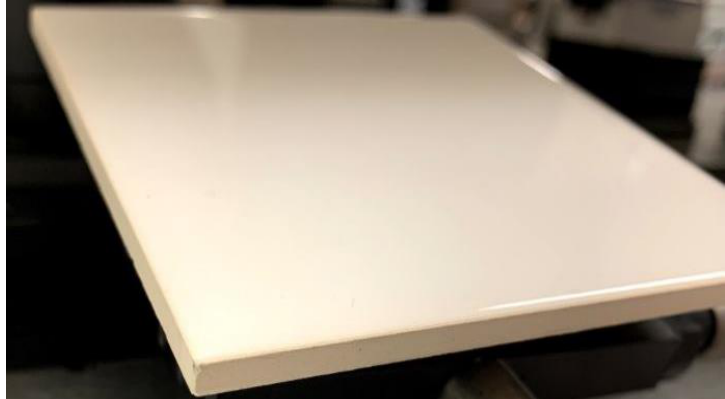
Figure 6. Photograph of the tile used in experiments.